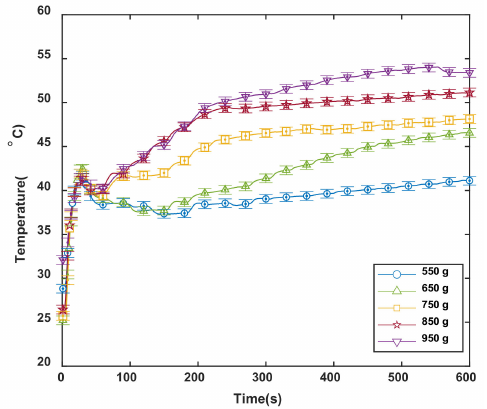
Figure 5. Variation in condensation temperature over time with refrigerant charge amount.